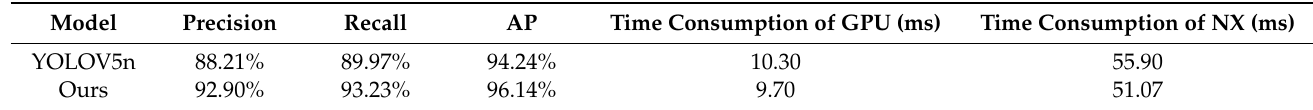
Table 2. Results of model comparison.